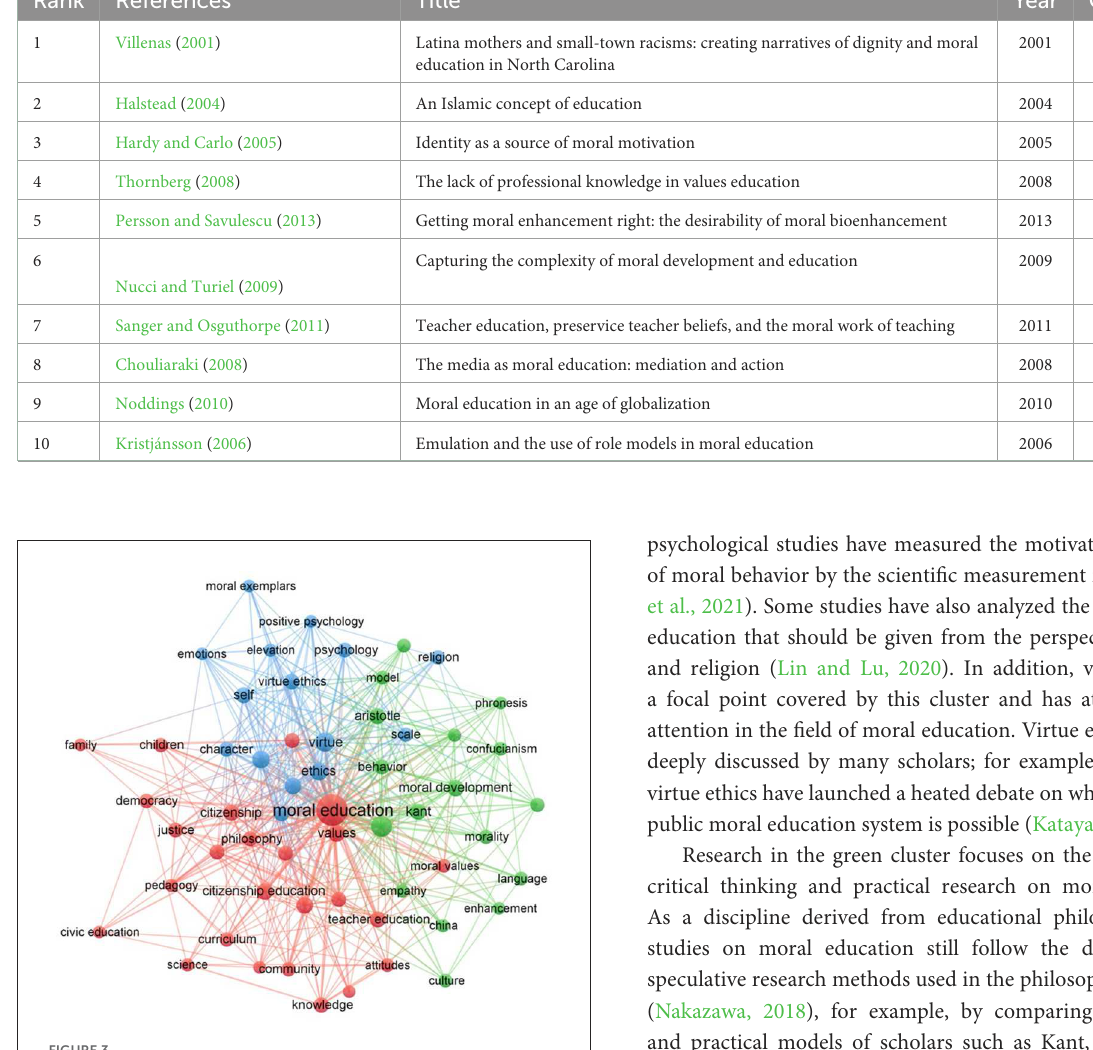
FIGURE3 Co-occurrence of